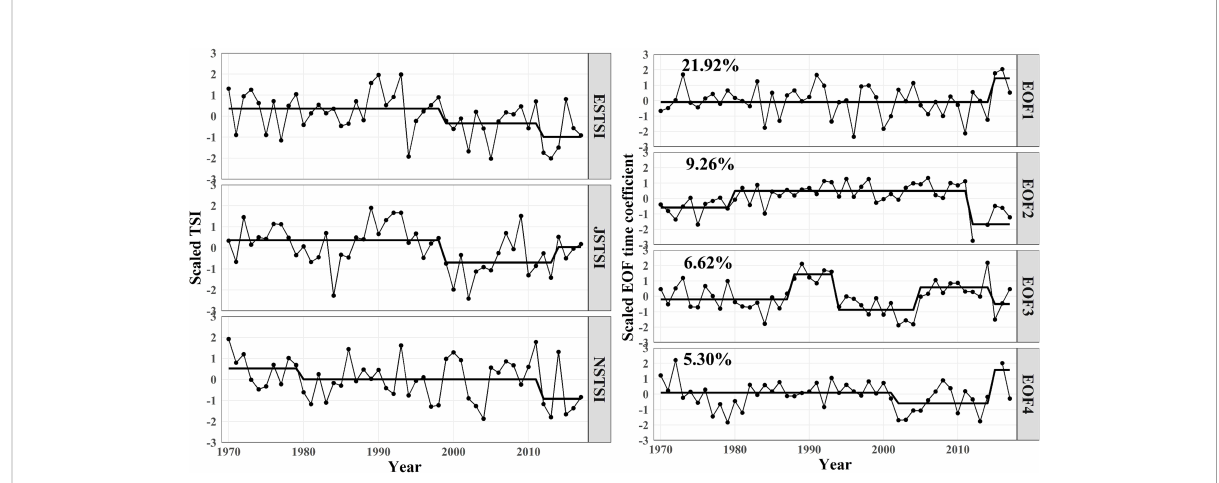
FIGURE 4 Trajectories in the average TSI of the coastal waters of China seas, the southern part of the Sea of Japan, and the Paci fi c coast of Japan during 1970-2017 (left panels) and the fi rst four modes of the EOFs. Numbers indicate the percentage of variance explained by each EOF. Black lines represent regime means calculated by the STARS (right panels).